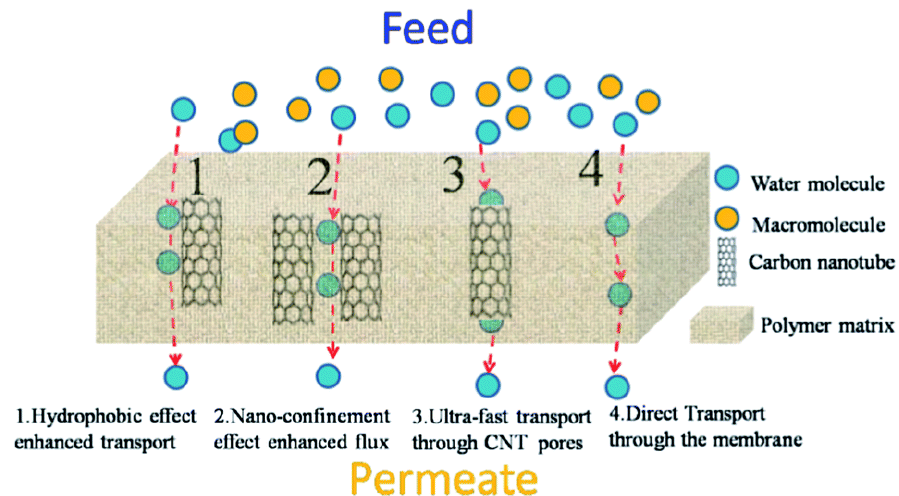
Figure 3. Illustration of possible pathways for water transportation in a CNT/polymer blend membrane due to ( 1 ) hydrophobic effect-enhanced transport, ( 2 ) nano-confinement-enhanced flux, ( 3 ) ultrafast transport through the CNT pores, and ( 4 ) direct transport through the membrane matrix [79].